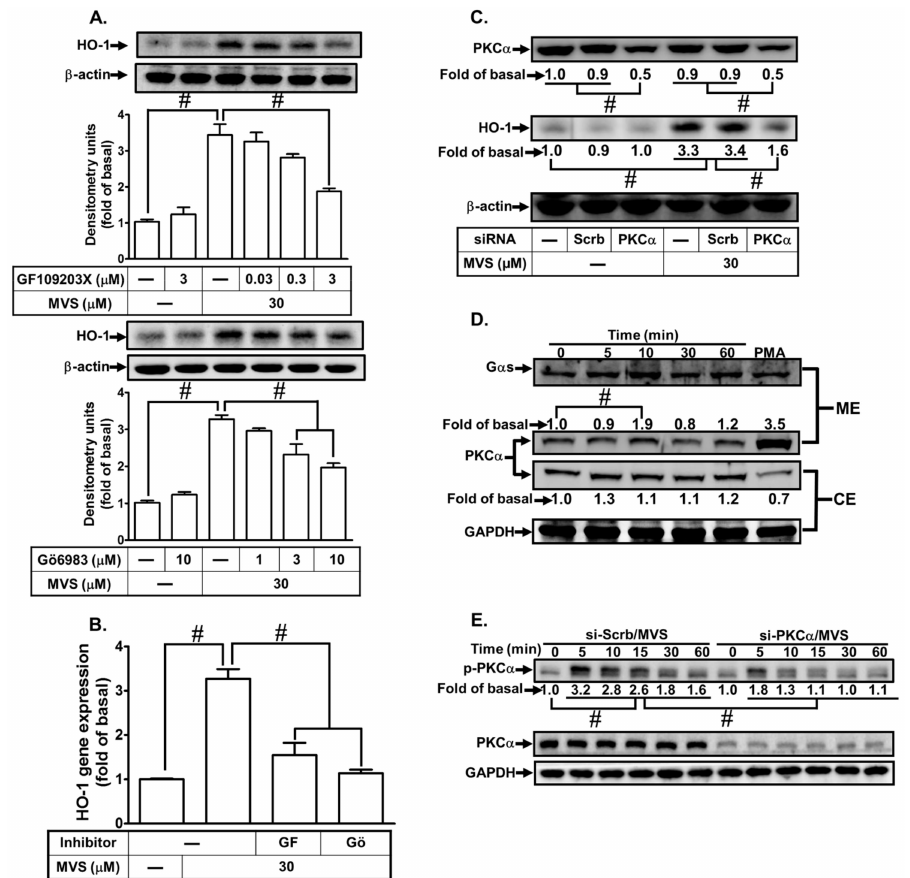
Figure 2. Protein kinase C (PKC) α is involved in MVS-induced HO-1 expression. ( A ) Cells were pretreated with various concentrations of GF109203X or Gö6983 for 1 h, and then incubated with vehicle or MVS (30 µ M) for 24 h. The levels of HO-1 and β -actin protein were determined by Western blot. ( B ) The cells were pretreated with GF109203X (3 µ M) or Gö6983 (10 µ M) for 1 h and then incubated with vehicle or MVS (30 µ M) for 8 h. The levels of HO-1 mRNA were determined by real-time qPCR. ( C ) HPAEpiCs were transfected with scrambled (Scrb) or PKC α siRNA, and then incubated with MVS for 24 h. The levels of HO-1, PKC α , or β -actin were determined by Western blot. ( D ) Cells were pretreated with MVS (30 µ M) for the indicated time intervals. The cytosol and membrane fractions were prepared and analyzed by Western blot using an anti-PKC α , anti-GAPDH, or anti-G α s antibody. ( E ) HPAEpiCs were transfected with scrambled (Scrb) or PKC α siRNA and then incubated with vehicle or MVS (30 µ M) for the indicated time intervals. The levels of phospho-PKC α , PKC α , and GAPDH were determined by Western blot using respective antibodies. Data are expressed as mean ± SEM of five independent experiments ( n = 5). # p < 0.01, as compared with the cells exposed to the indicated